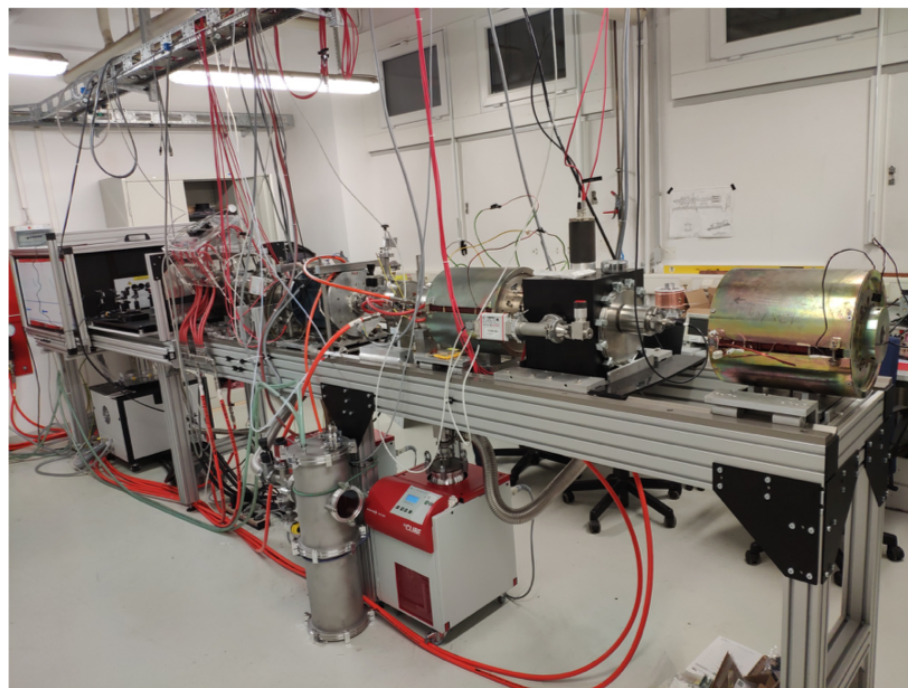
Figure 14: Photo of Ju SPARC_MIRA and the Lamb-shift